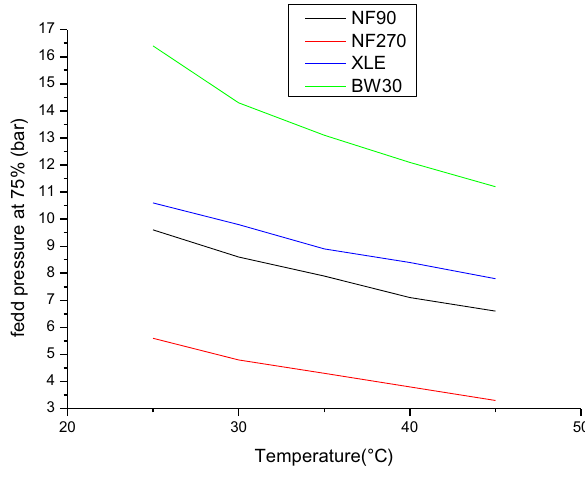
Fig. 3 Effect of temperature on feed pressure to achieve 75% of RR